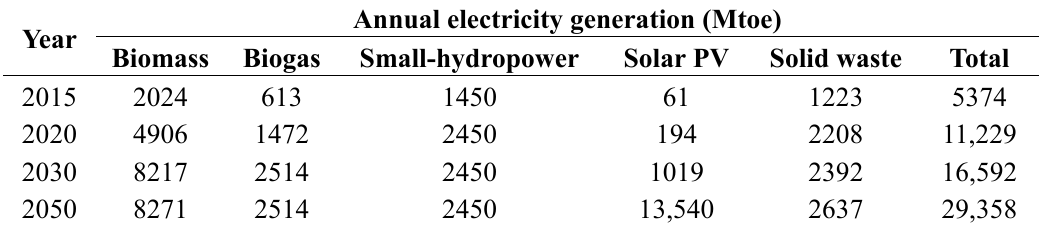
Table 12. Policy target of electricity generation from renewable energy in Malaysia (The electricity generation value are in the SQ